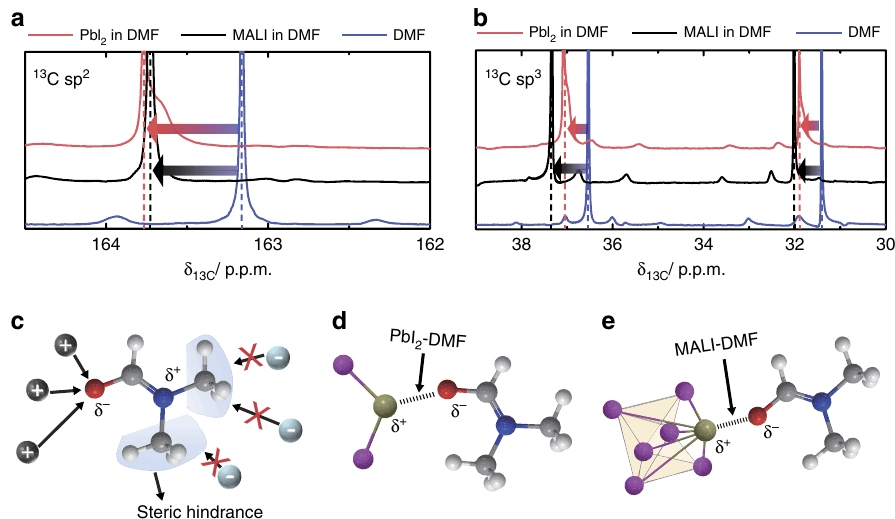
Figure 4 | Dissolution mechanism of MALI in a polar aprotic solvent. ( a ) 13 C sp 2 and ( b ) 13 C sp 3 chemical shifts of PbI 2 –DMF and MALI-DMF away from the corresponding signals for a pure DMF solution. ( c ) Scheme of the resonance structure of DMF, with a partially positive and negative polarity. Chemical bonding structures of the ( d ) PbI 2 and ( e ) PbI 6 frames of MALI with the partially negative oxygen of DMF. (Red spheres: oxygen, blue spheres: nitrogen, grey spheres: carbon, white spheres: hydrogen, yellow spheres: lead, violet spheres: